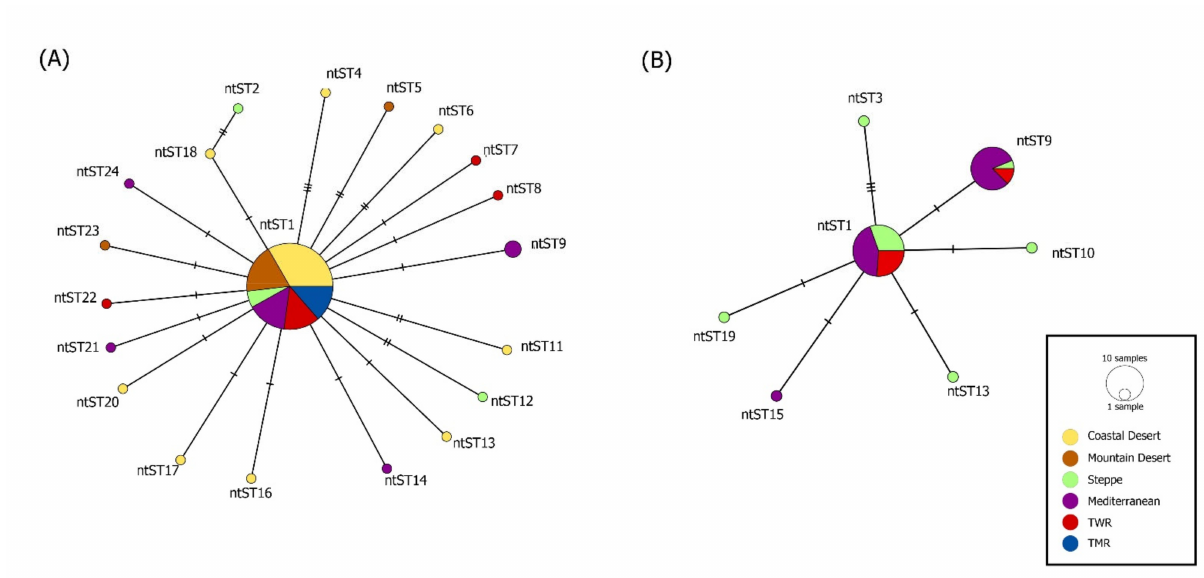
Figure 3. ( A ) Median-joining network of the 16S rRNA gene (322bp) of Mycoplasma haemocanis in rural dogs from different bioclimatic regions. ( B ) Median-joining network of the 16S rRNA gene (356bp) of Mycoplasma haemocanis in foxes from different bioclimatic regions. The color of the circles corresponds to the bioclimatic region where the ntST were detected. Each circle in the networks corresponds to a different nucleotide sequence type (ntST), and the size of the circles corresponds to ntST frequencies.